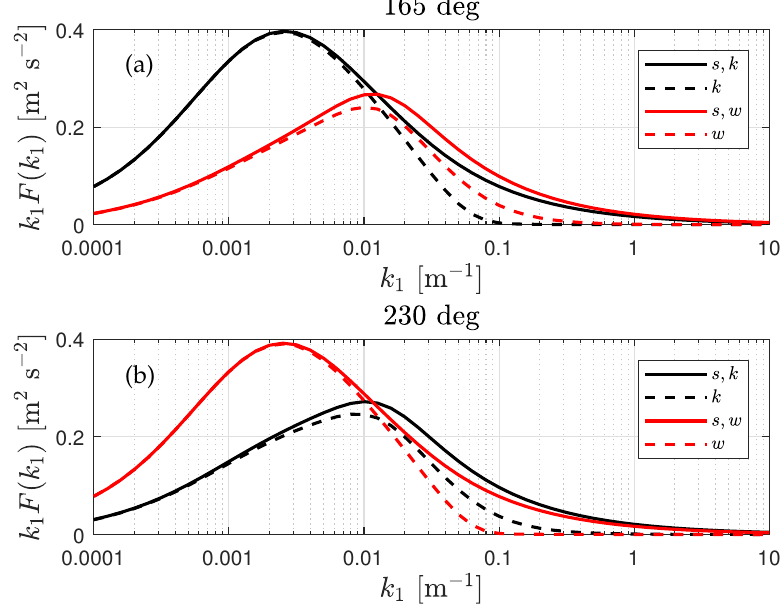
Figure 5. Radial velocity spectra of the k and w WindScanners and those of an ideal sonic anemometer aligned with either WindScanner ( s , w or s , k ) for two wind directions: 165 ◦ ( a ) and 230 ◦ ( b